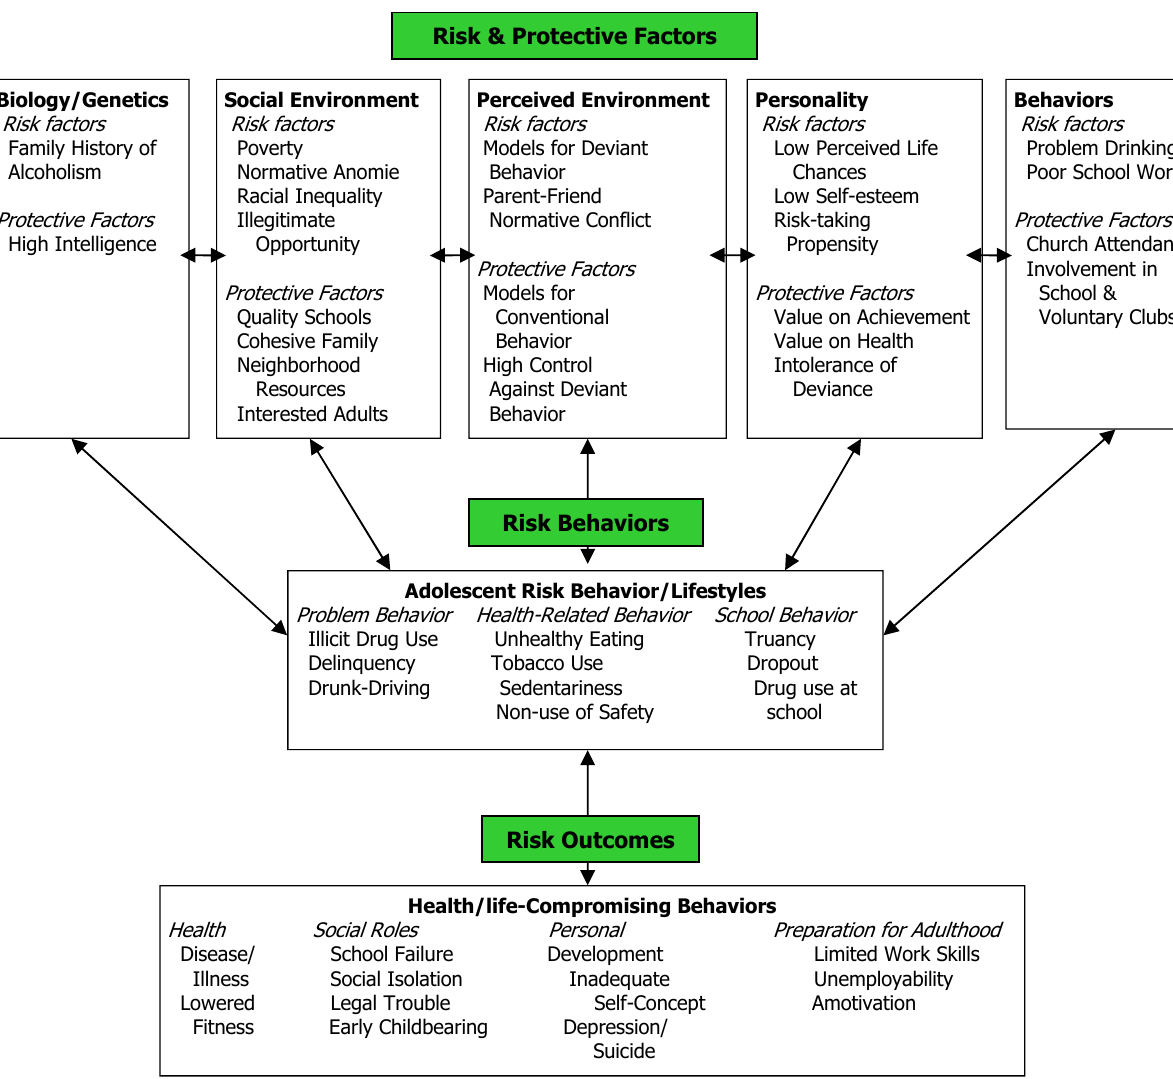
Interrelated Conceptual Domains of Risk Factors and Protective Factors Risk & Protective